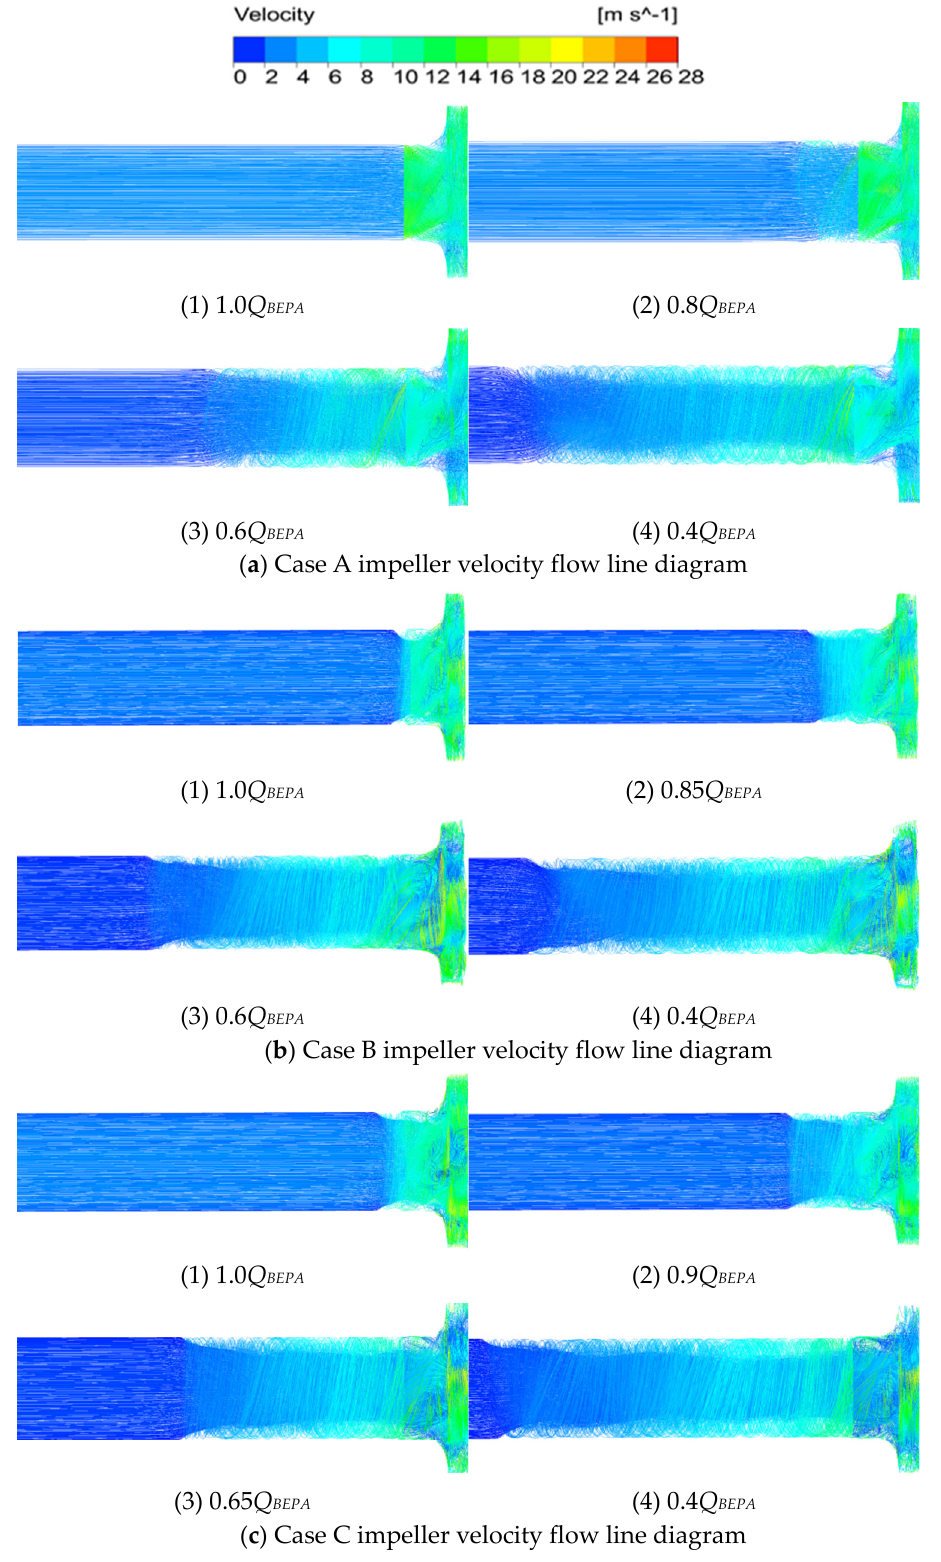
Figure 8. The velocity streamlines distribution at different flow rates.